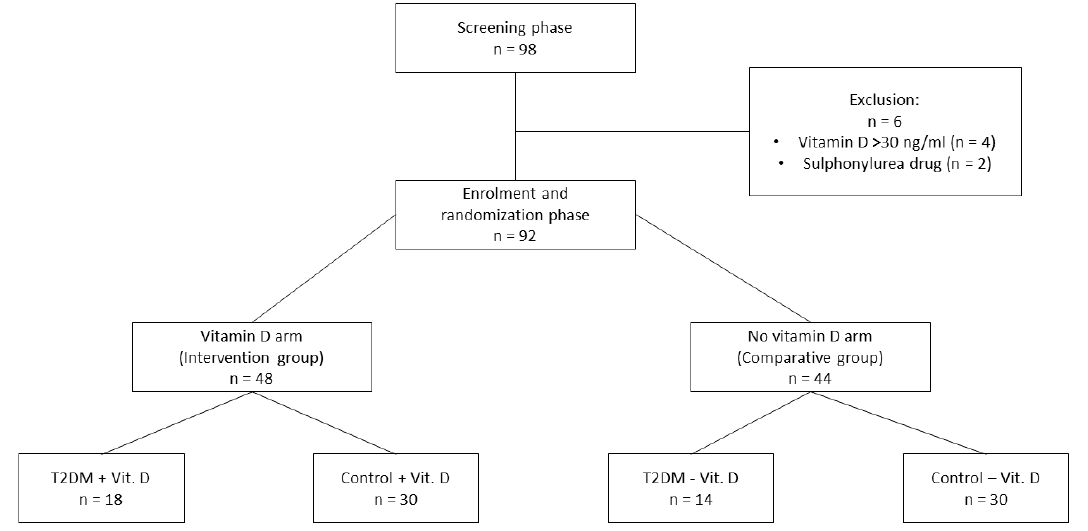
Figure 5. Patient flow diagram.